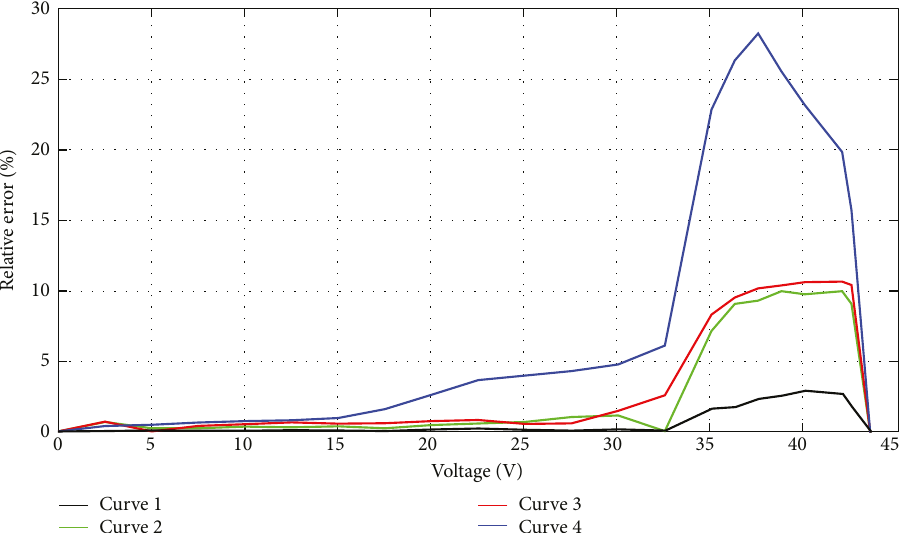
Figure 7: Relative errors of the model proposed in this paper (curve 1), in [4] (curve 2), in [12] (curve 3), and in [6] (curve 4) for the FS-270 PV module at 25 ° C and 1000 W/m 2 . Table 4: Comparison of R model, R and R model, two-diode model, and proposed model output with manufacturer ’ s datasheet for Shell s s p ST40 PV module [30].